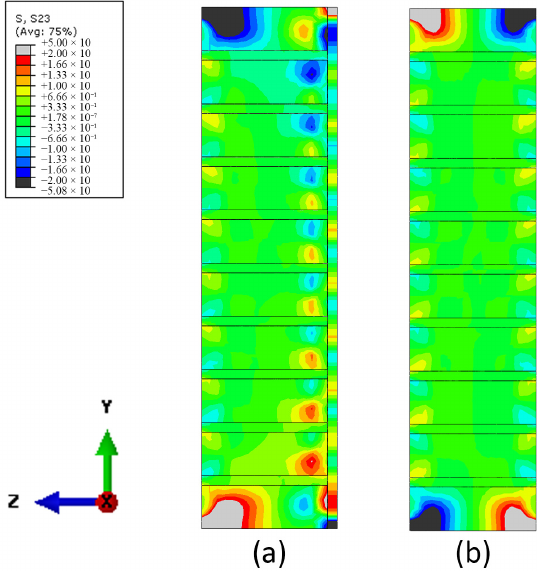
Figure 16. Comparison of ultimate strength from experimentation, FE numerical versus k1.